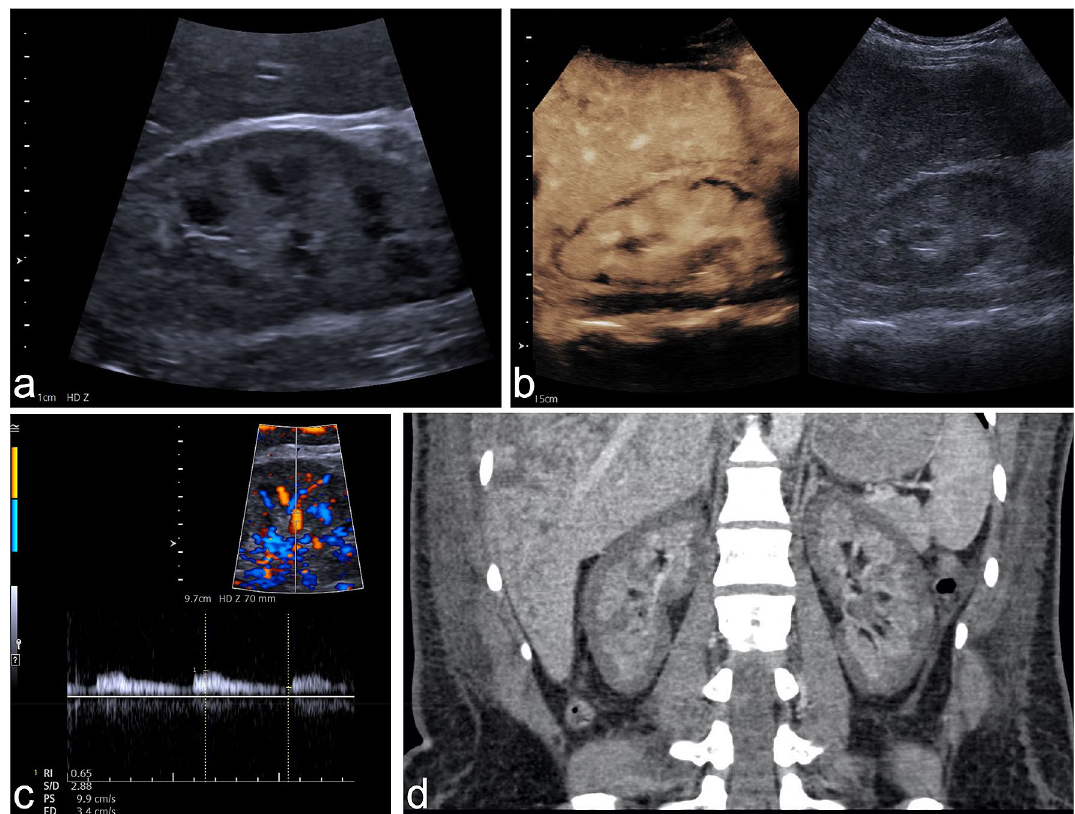
Figure 1. Example of RCN of the native kidney in a 28-year-old woman suffering from massive postpartum bleeding with acute kidney failure and HELLP syndrome. ( a ) B-mode image of the right kidney showing a hypoechoic rim of 3–4 mm. ( b ) CEUS of the right kidney showing a subcapsular loss of contrast enhancement of 3–5 mm. ( c ) Triplex sonography of the right kidney with a PW spectrum of an interlobar artery showing a normal resistance index of 0.65. ( d ) Coronal venous-phase CT scan obtained 14 days before CEUS examination showing a recess of contrast agent measuring up to 6 mm in both kidneys, confirming the diagnosis of RCN. CEUS denotes contrast-enhanced ultrasound, RCN, renal cortical necrosis, HELLP syndrome denotes hemolysis, elevated liver enzymes, low platelets, PW, pulsed-wave